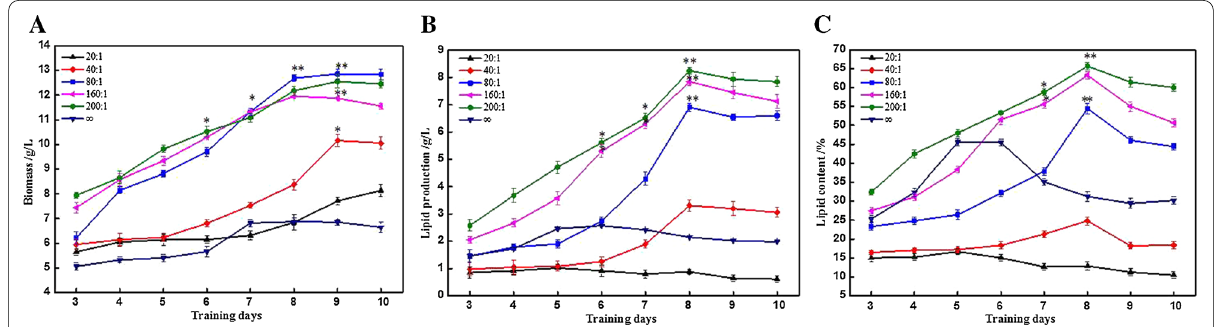
Fig. 3 Changes of biomass ( A ), lipid production ( B ), lipid content ( C ) of R-ZL2 in different C/N ratios (the 4% sucrose as the carbon source, ammonium nitrate as the nitrogen sources). Data are presented as the average of three independent experiments. Error bars represent